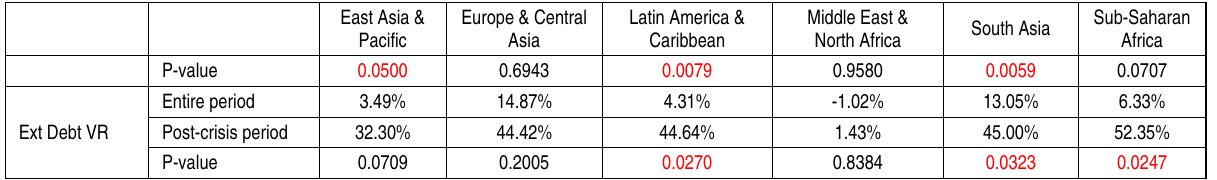
Table 5 (cont.). Growth rates of total gross external debt, PPG external debt, ST external debt, and VR